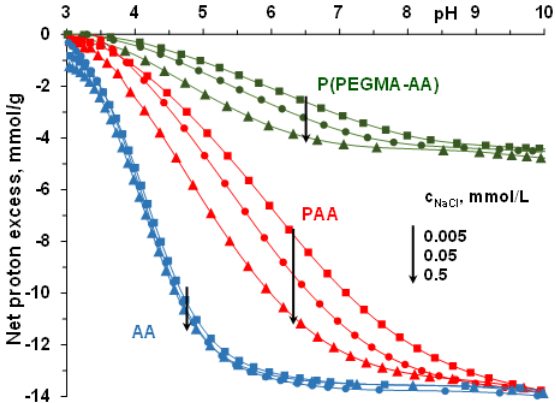
Figure 1. pH- and ionic strength-dependent dissociation of acrylic acid (AA), polyacrylic acid (PAA) and P(PEGMA-AA): –COOH + OH − → –COO − + H 2 O reaction taking place with base addition. The lines connect experimental data points.